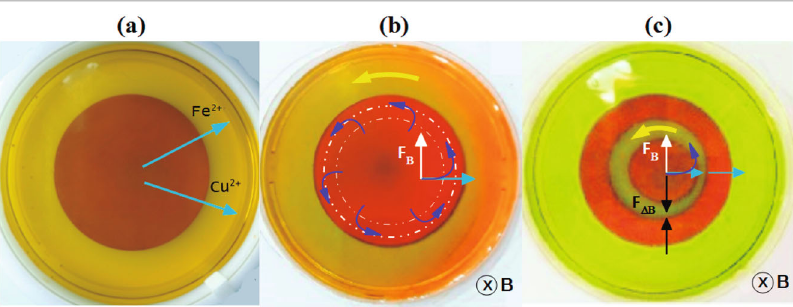
Fig. 6 Schematic drawing of the effect of mass transport of iron and copper ions on the corrosion pattern and rate. a Corrosion in absence of B showing the preferential movement of the cations. b Corrosion in presence of homogeneous B where the light blue arrow indicates the radial diffusion of Cu 2 + and Fe 2 + , white arrow, the direction of F B and dark blue curved arrows the de fl ection of the cations by F B , and the yellow arrow the rotation of corrosive medium, and c corrosion in presence of inhomogeneous B where the black arrows indicate the F Δ B .